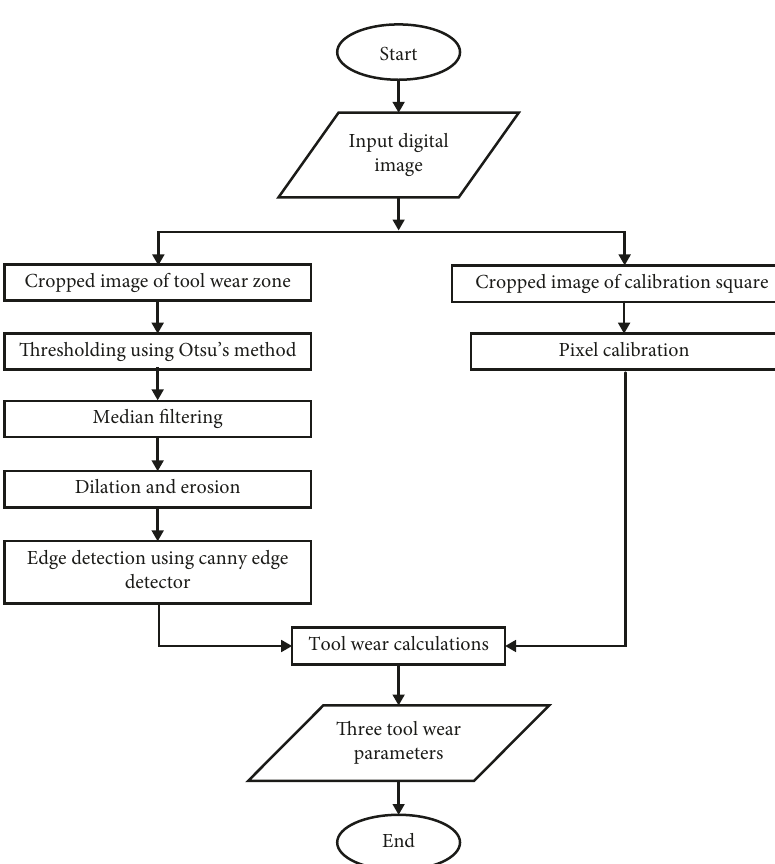
Figure 4: Flowchart of the algorithm for image processing.